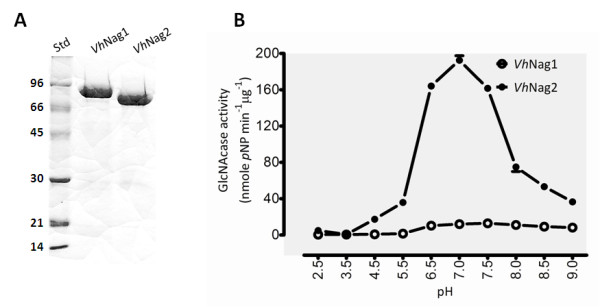
Physical properties of V. harveyi GlcNAcases. A) SDS-PAGE analysis of VhNag1 and VhNag2 expressed in E. coli and purified by Ni-NTA agarose chromatography. Std: low molecular weight protein markers. B) pH/activity profiles of VhNag1 and VhNag2. GlcNAcase activity was assayed at different pH values from 2.5 to 9.5 at 37°C for 10 min using pNP-GlcNAc as substrate